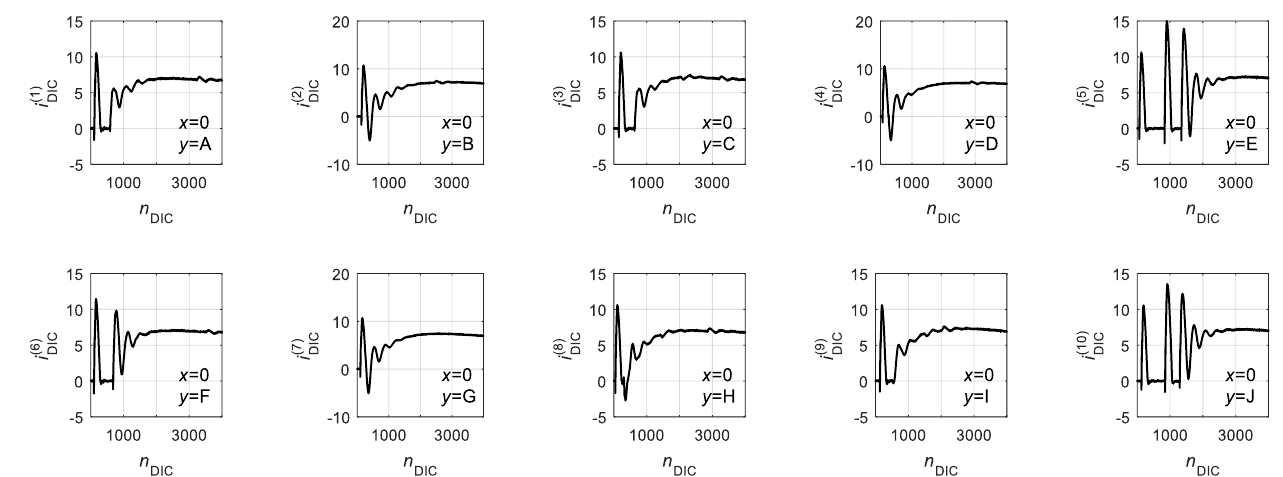
i for dictionary elements for the category no EA = ( 0 ) x . Figure 20. Current vectors DIC